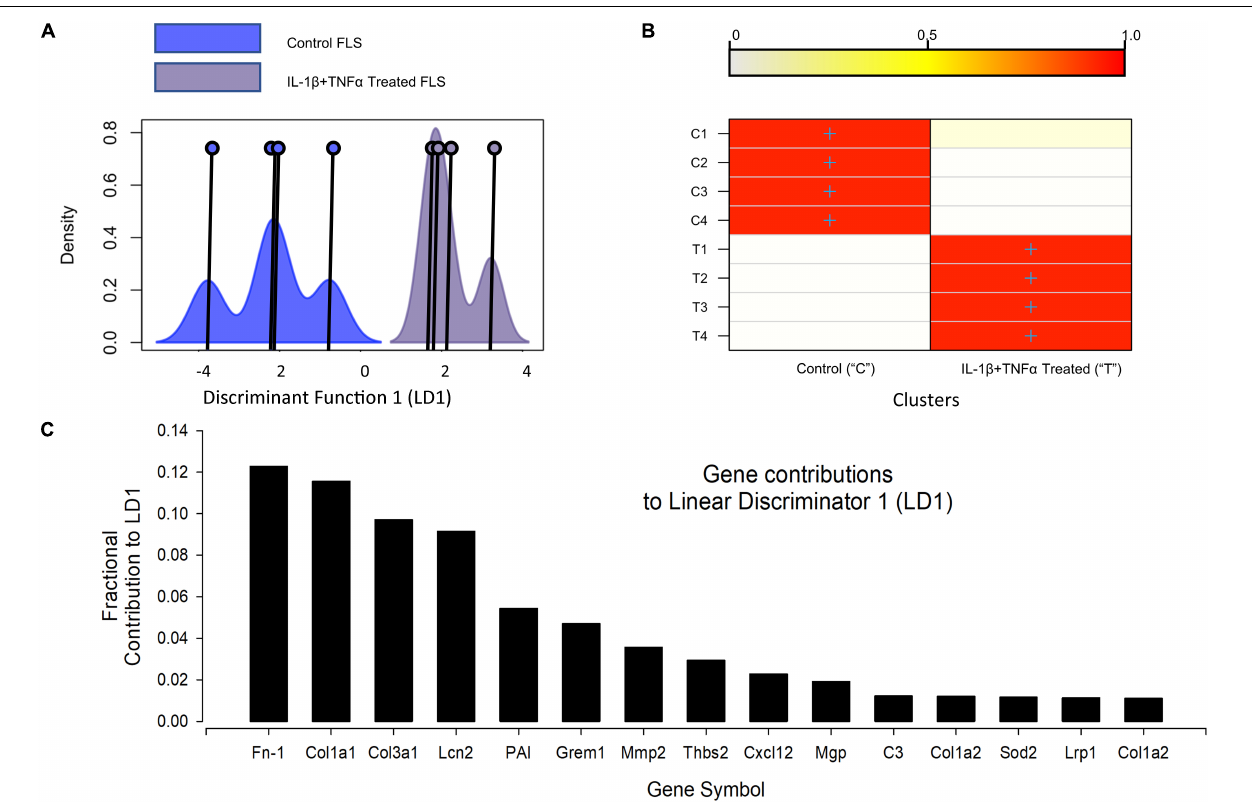
FIGURE 2 | Discriminant analyses of global IL-1 β TNF α treatment effects. (A) Shows the kernel density plots of the discriminant component co-ordinates for the control and IL-1 β /TNF α treatment groups; co-ordinates on the x -axis and density on the y -axis; Individual co-ordinate center points are illustrated by the vertical line and circle. There is clear separation between control and cytokine treated FLS samples. (B) A graphical confusion matrix showing the actual group membership ( y -axis) and predicted cluster membership (on the y -axis). All groups are correctly clustered with greater than 0.9 probability. (C) The top 15 contributors to the